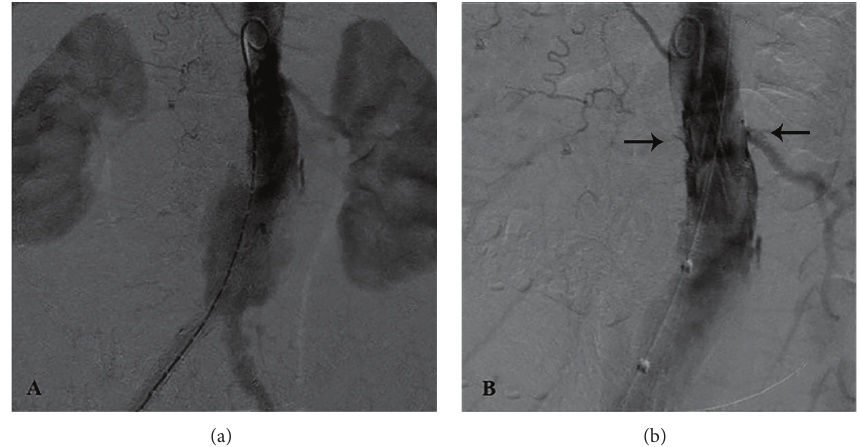
Figure 2: Completion angiogram after stent-graft deployment showing type 1a endoleak (a). After aortic cuff extension placement, both renal arteries were covered (arrows) (b).